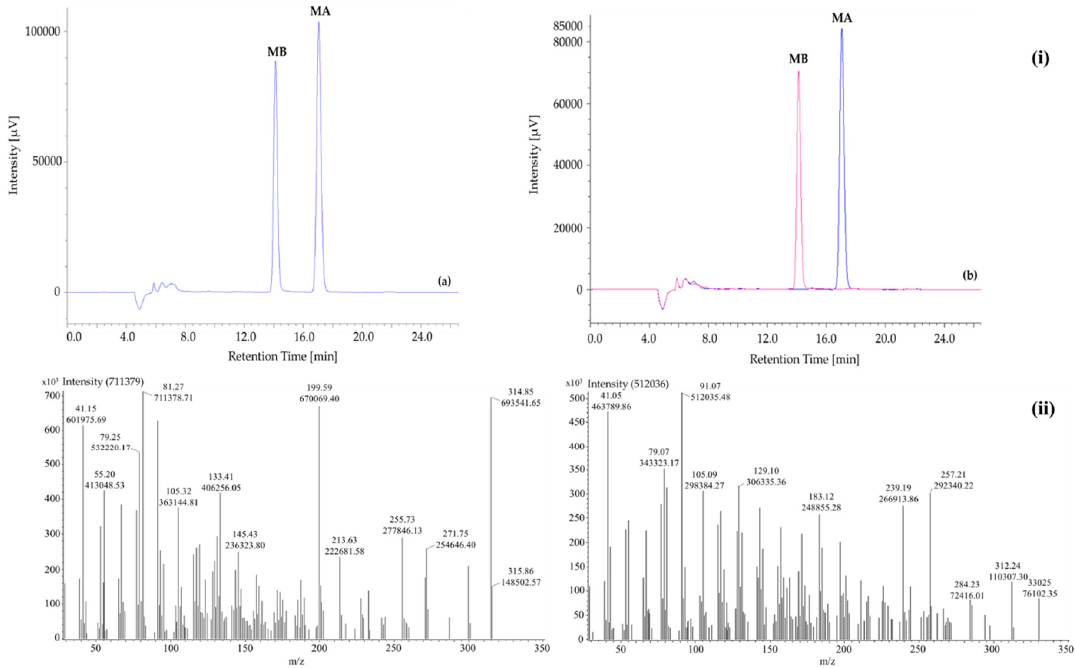
Figure 2. ( i ) HPLC chromatograms of momilactones A and B: ( a ) mixture of standard momilactones A (MA) and B (MB), ( b ) isolated momilactones A and B (overlaid chromatogram); and ( ii ) Mass spectra of the purified ( a ) momilactone A and ( b ) momilactone B.